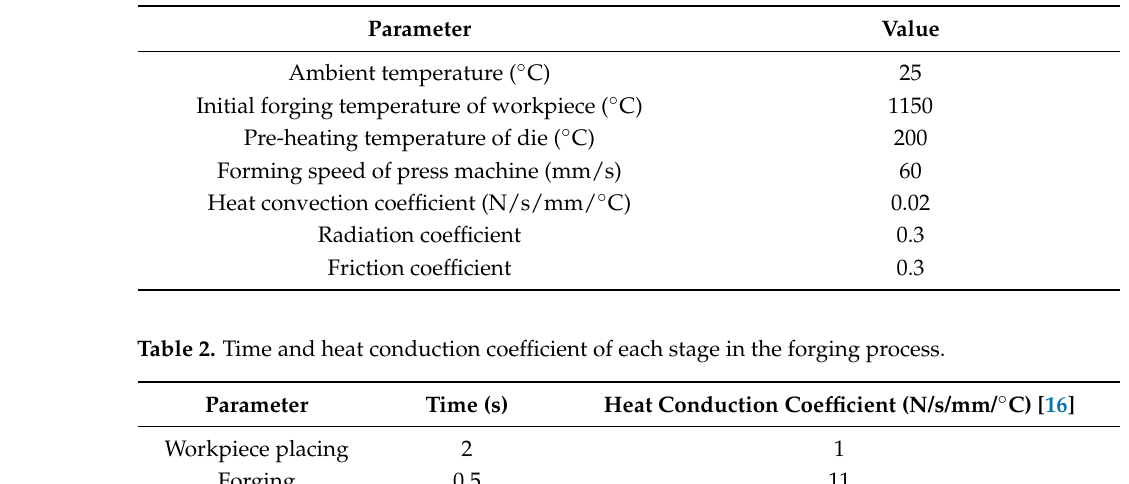
Figure 2. Three-dimensional model and temperature–stress fields of the die. ( a ) Three-dimensional model. ( b ) Temperature. ( c ) Effective stress. ( d ) Temperature and stress at L1 and L2. Table 1. Parameters of forging process in the simulation.